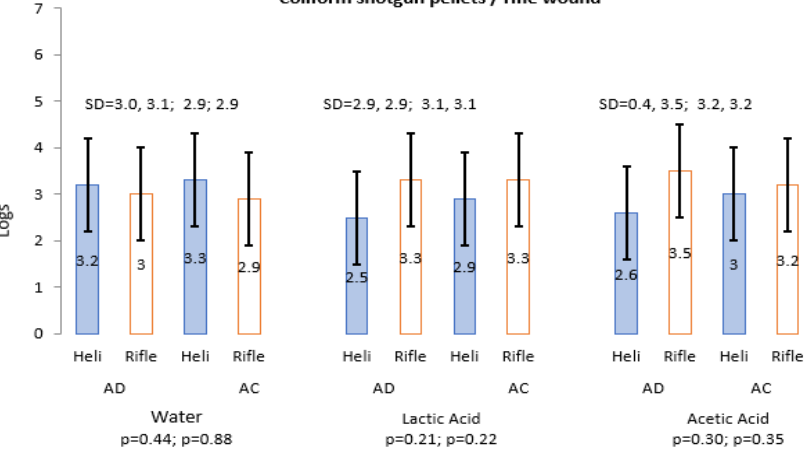
Figure 3. Average log counts of coliform helicopter and rifle wound before and after water, LA and AA treatment.